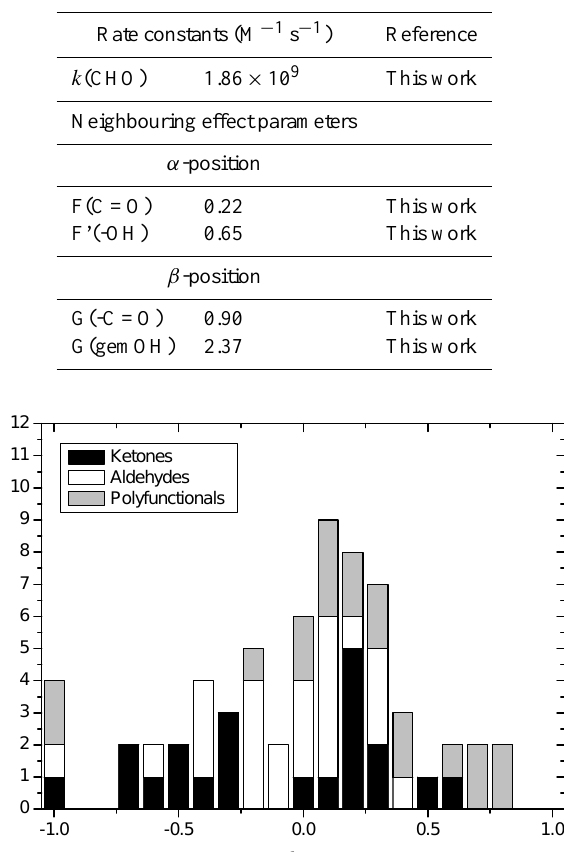
Fig. 1. Correlation plot between the calculated and the experimental rate constants of aqueous phase OH-oxidation of carbonyl compounds in linear (left) and logarithmic scales (right). The straight line is the linear regression curve: y =(1.01 ± 0.06) · x − (0.4 ± 1.4) × 10 8 with r 2 =0.77. The dashed lines define the limits where the rate constants are calculated within a factor of 2 from the experimental data. Table 5. Chemical parameters to be used for the extension of the SAR to carbonyl compounds and gem-diols.